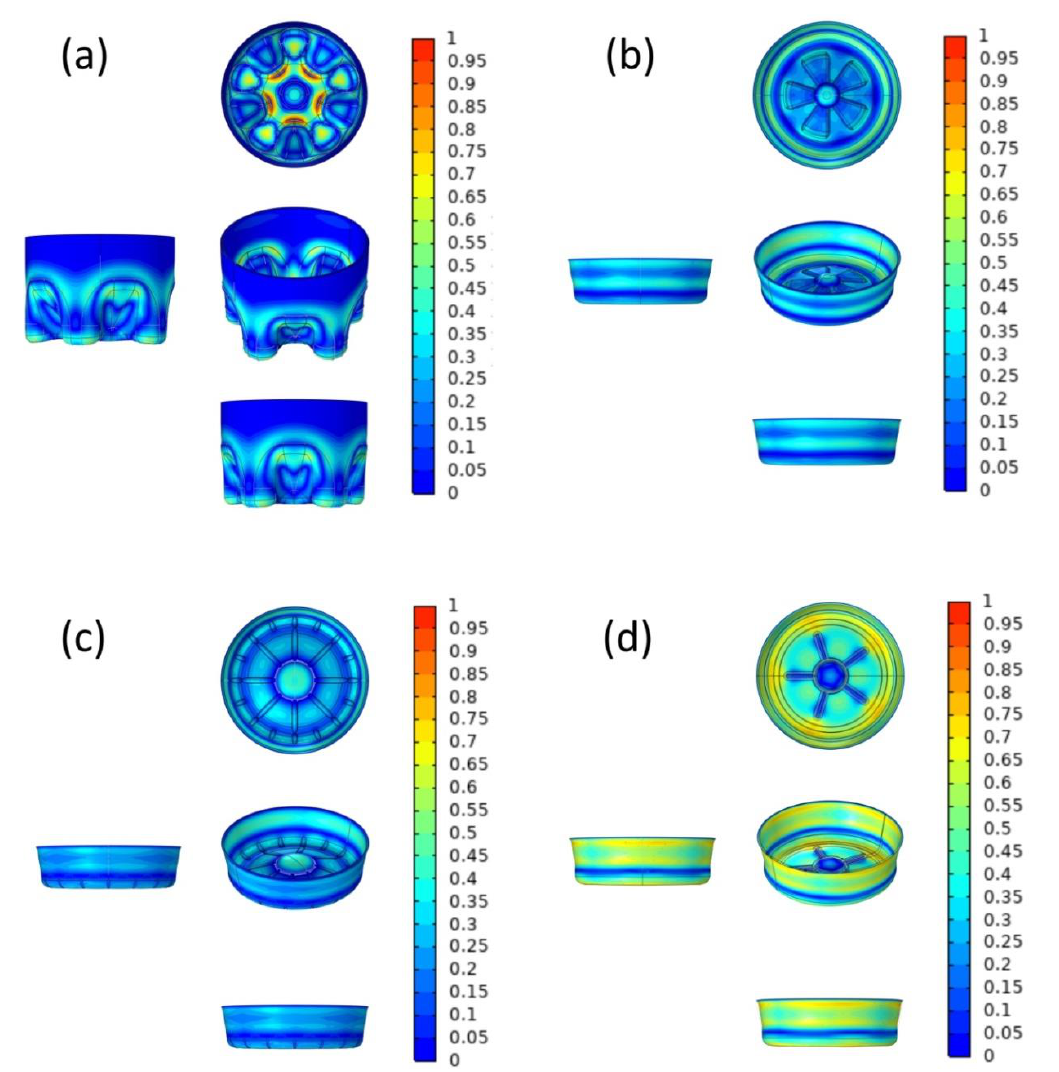
Figure 3. Comparison of model structures CF-bottom ( a ), PP-bottom ( b ), PR-bottom ( c ), and OR-bottom ( d ) before and after optimization. Table 4. Comparison of the overall maximum stress of the models.